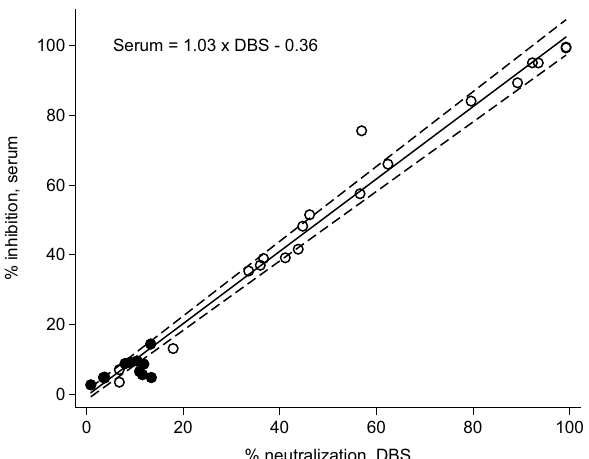
Serum = 1.03 x DBS - 0.36